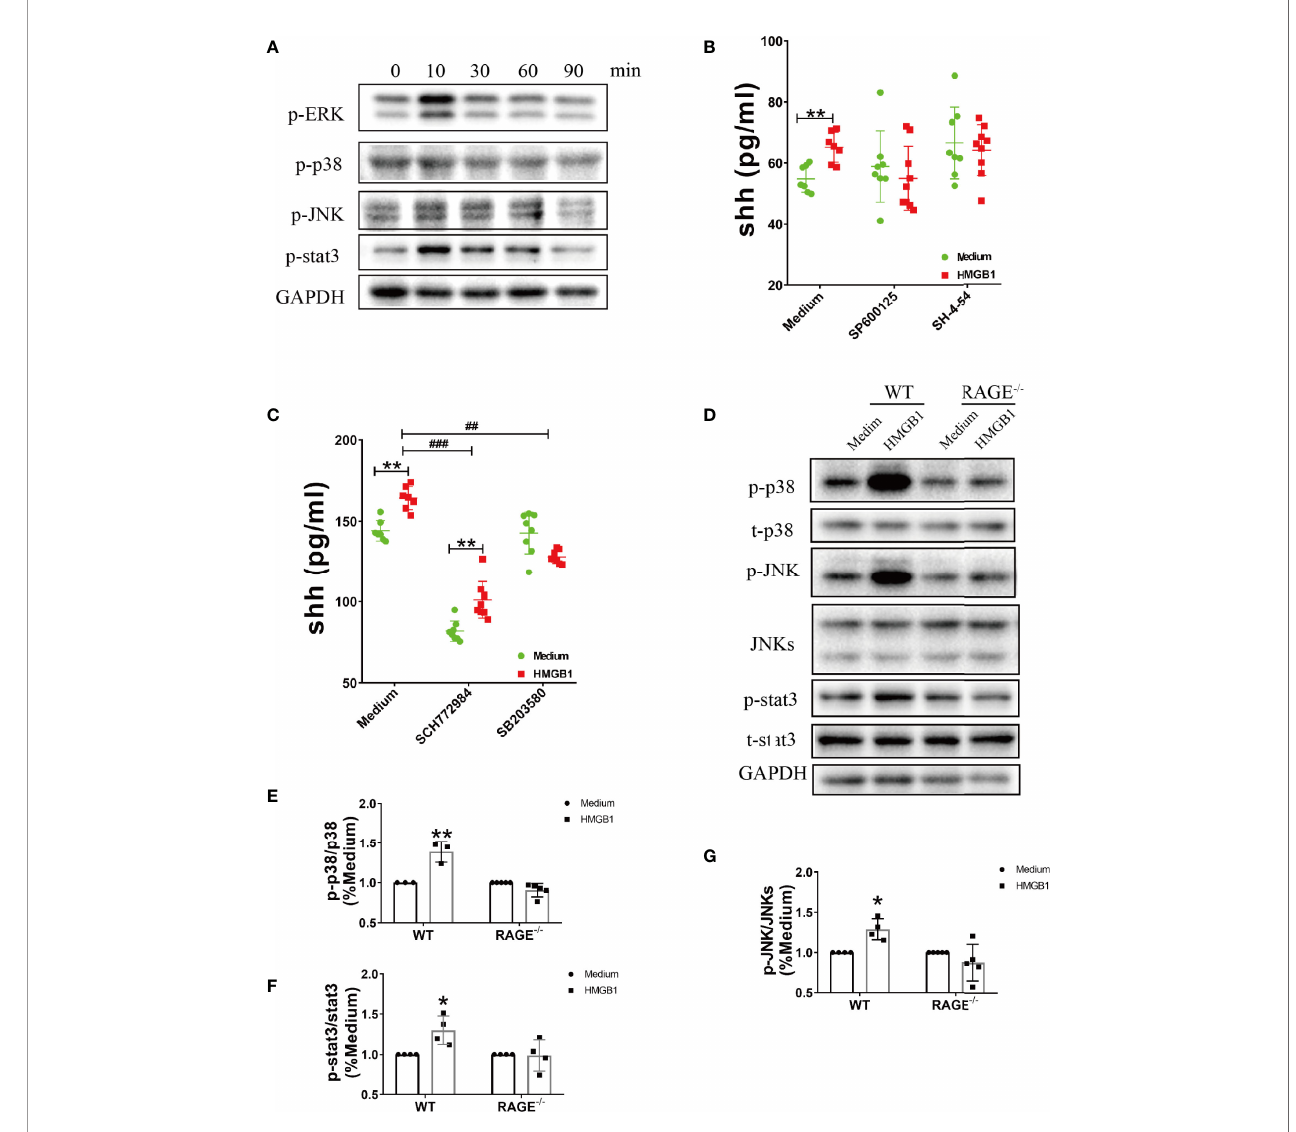
FIGURE 3 | The signal pathways involved in the effect of HMGB1 on promoting shh release from astrocytes through receptor RAGE. (A) The change of phosphorylation-ERK, p38, JNK and stat3 after HMGB1 (1 m g/ml) stimulation. (B, C) The effect of JNK blocker (5 m M SP 600125), stat3 blocker (10 m M SH-4-54), ERK blocker (2 m M SCH 772984) and p38 blocker (3 m M SB 203580) on shh release from astrocytes after HMGB1 (1 m g/ml) stimulation for 10 min. (D) The change of phosphorylation-p38, JNK and stat3 after HMGB1 (1 m g/ml) stimulation for 10 min in RAGE -/- astrocytes comparing to WT astrocytes. (E – G) Data analysis for panel (D) . Data are shown as mean ± SD (* P < 0.05, ** P < 0.01 compared with medium; ## P < 0.01, ### P < 0.001 compared with each